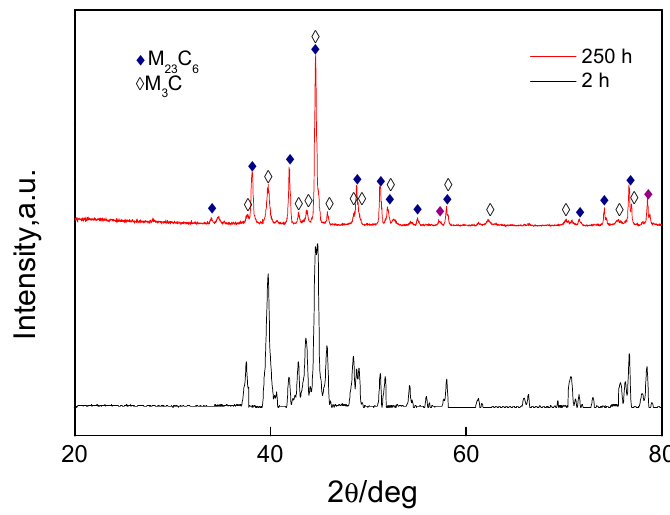
Figure 4. Patterns of precipitate extracted from samples tempered at 680 °C for 2 h and 250 h, reproduced from [19], with copyright permission from Elsevier, 2014.